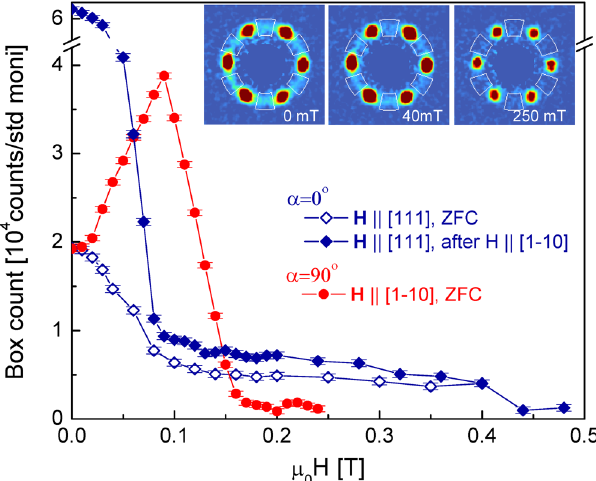
Figure 5. SANS intensity due to a single rhombohedral domain. Field dependence of the SANS intensity measured for selected parts of the ring structure within the white sectors, as shown in the SANS images recorded in 0, 40 and 250 mT with H ‖ [111]. The three curves correspond to the three measurement configurations presented in Fig.